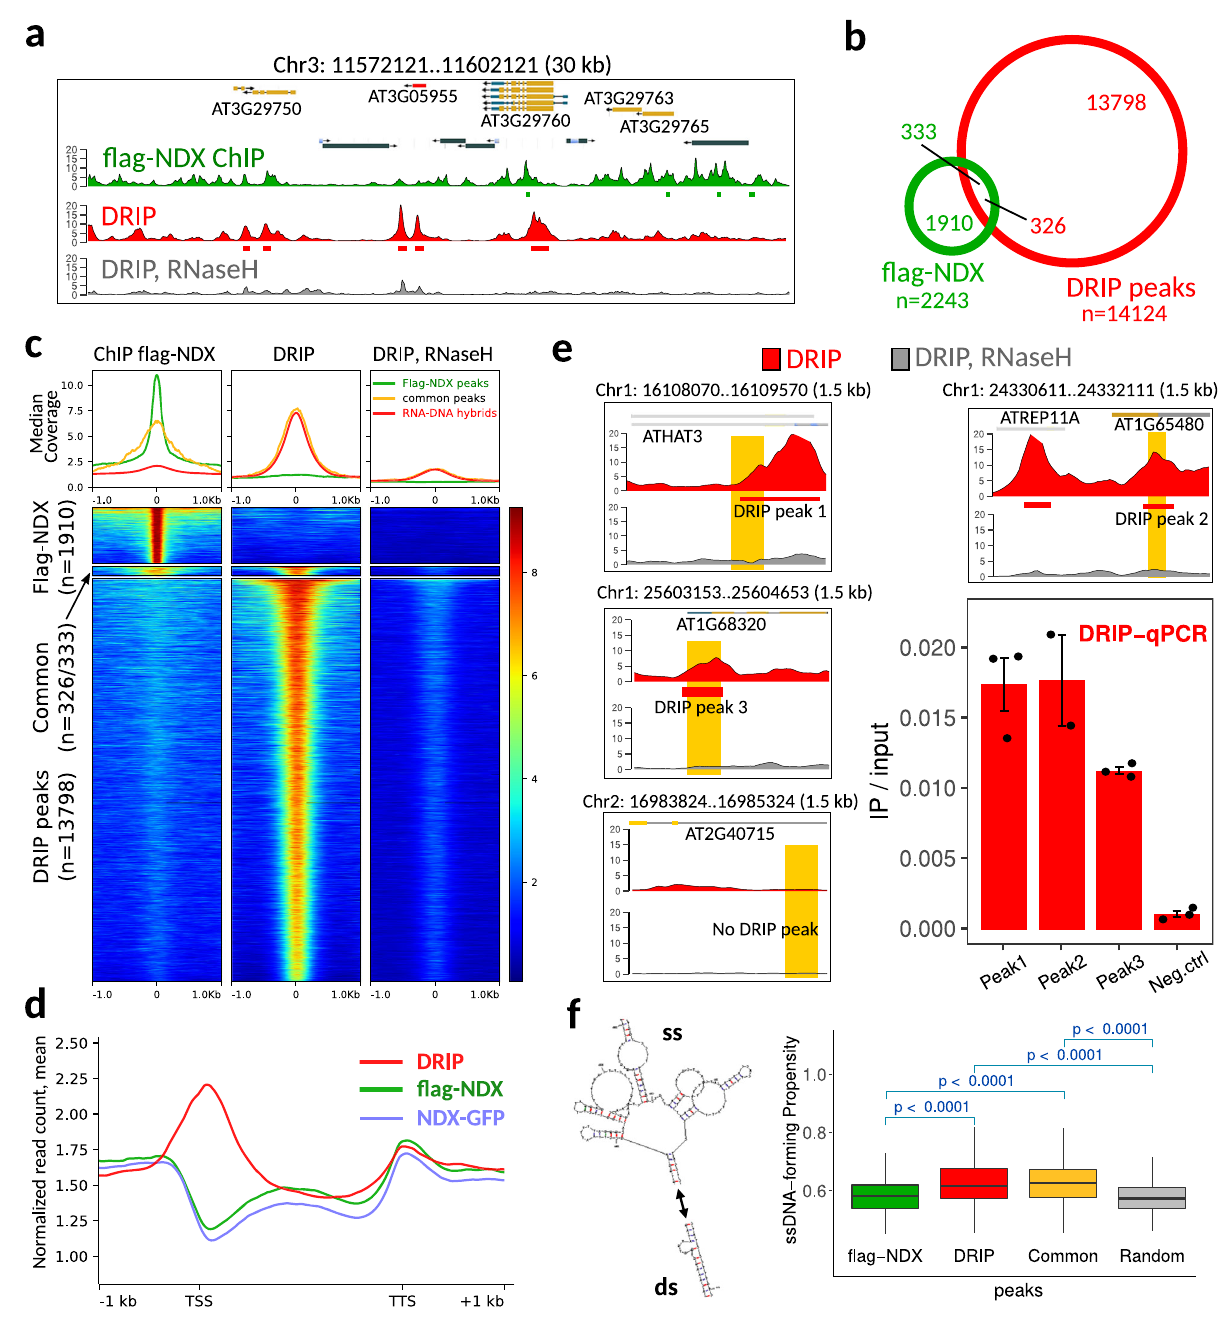
Fig. 3 | Antagonistic genomic distribution of NDX binding sites and R-loops. a Genomebrowsersnapshotshowing theenrichmentof fl ag-NDXandDRIPsignals along chromosome 3. RNase H-treated sample represents the background DRIP signal. RNA-DNA hybrids were immunoprecipitated by S9.6 monoclonal anti- bodies. b Venn diagram showing the overlapof fl ag-NDXpeaks and DRIP